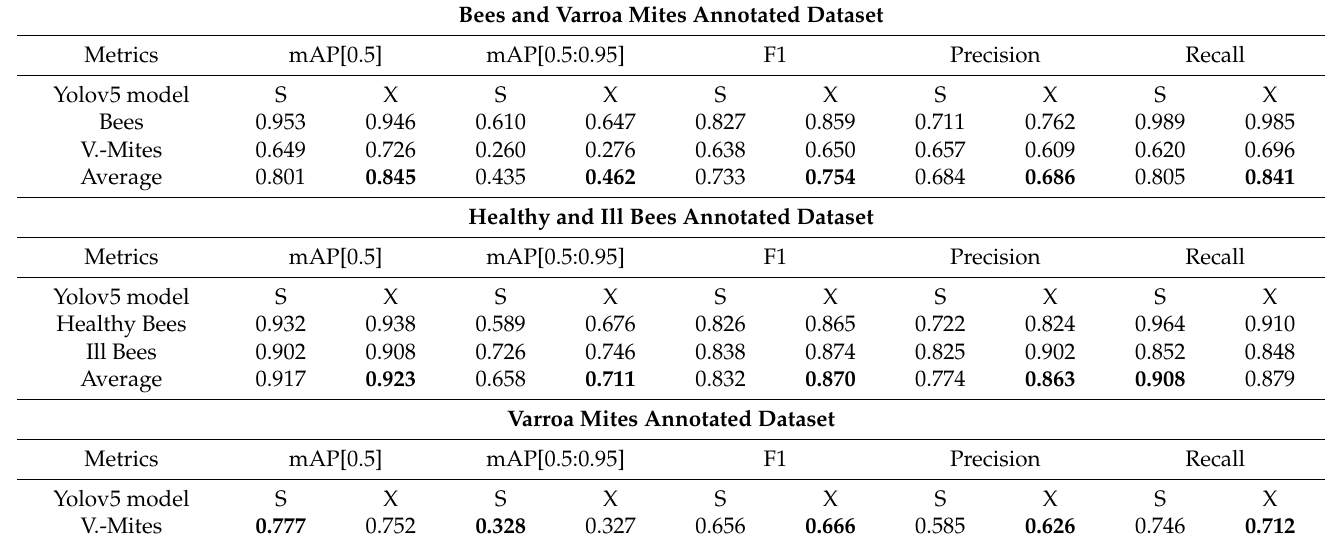
Table 6. Test score achieved by the YOLOv5 models on all datasets variants. The best results in V.-mite detection achieved by the YOLOv5 X model for the Healthy and Ill bees